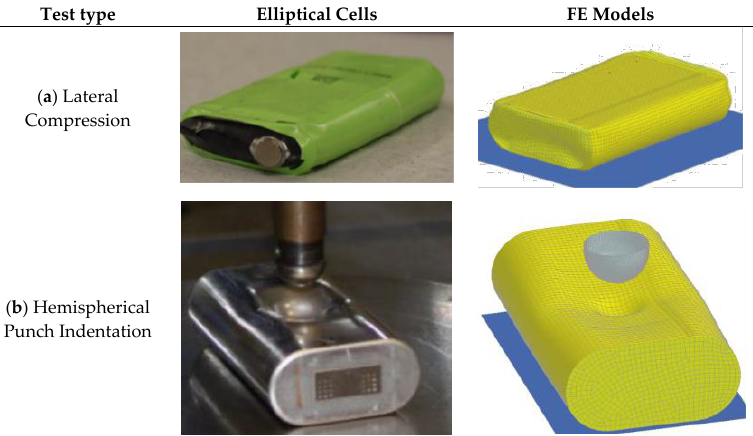
Figure 6. Experimental setup and deformation of elliptical cells and the corresponding finite element models. The figures are from the study presented in [45]. ( a ) Lateral Compression; ( b ) Hemispherical Punch Indentation